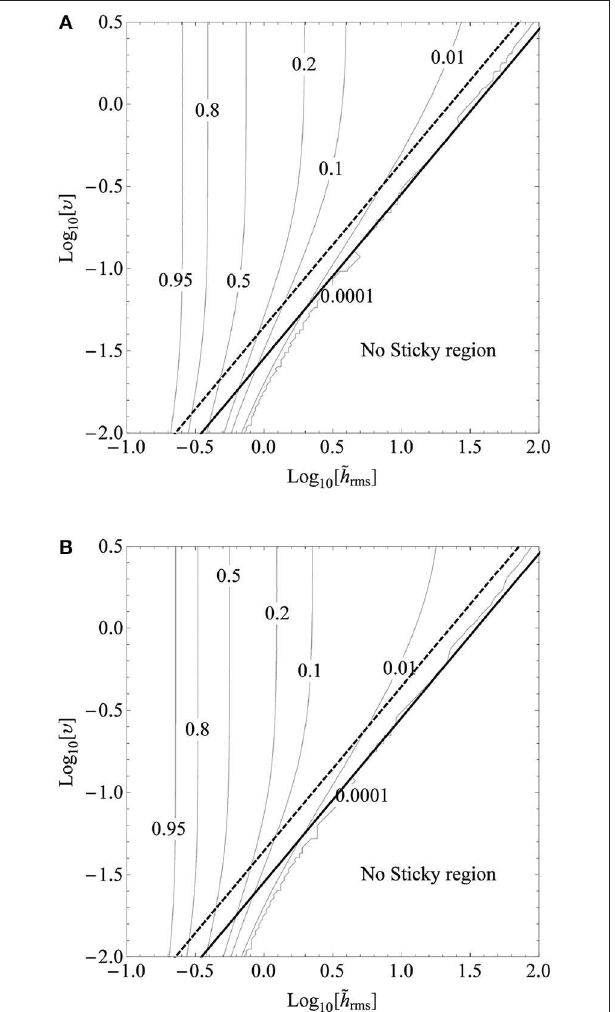
p max ext / σ 0 as a function of υ and FIGURE 7 | Pull-off mean pressure λ L (log-log scale) for 2,048: (A) insulating solids; (B) conducting solids with = e d 0 200. The thick black solid and dashed lines indicate the stickiness limits e = e obtained, respectively, with BAM (Equation 32) and by following the Persson e and Tosatti energy balance for H 0.8 (Equation =